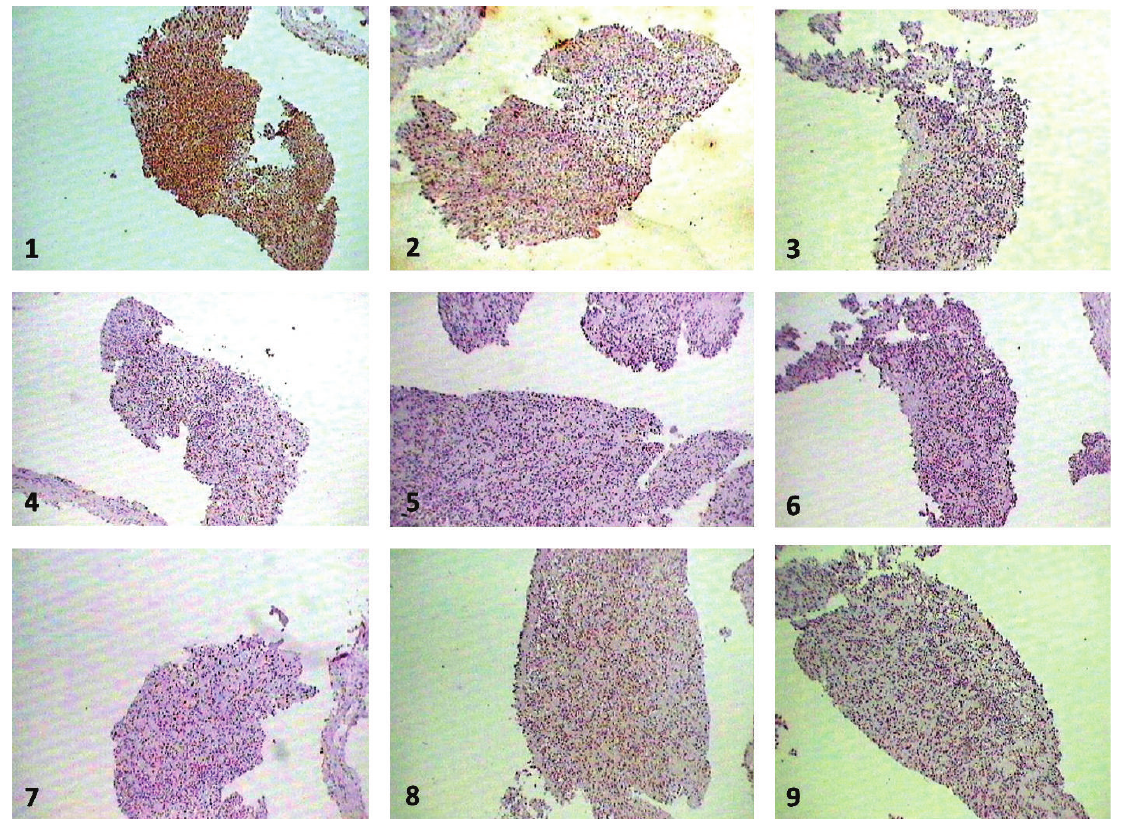
Figure 4: Microphotograph of immunohistochemistry showing tumour cells positive for synaptophysin (1) and occasionally for Ki-67 (2) and negative for CEA (3), CD 56 (4), calretinin (5), desmin (6), pan-cytokeratin (7), TTF1 (8), and WT1 (9)